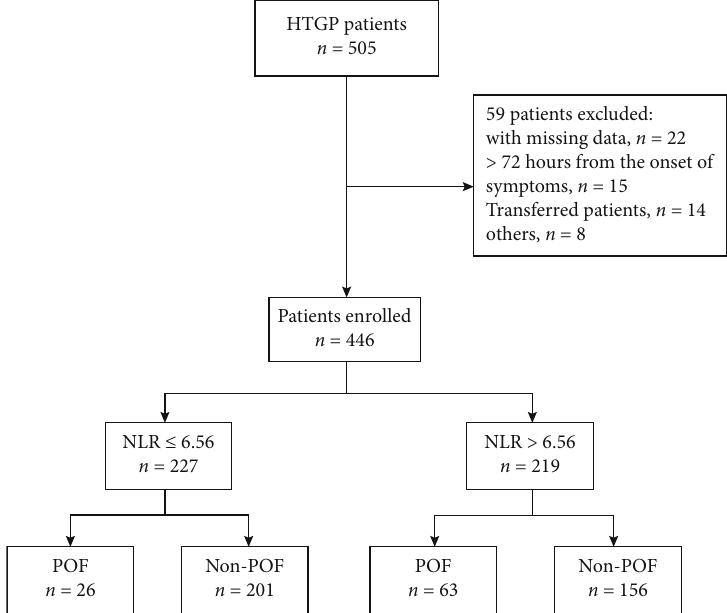
Figure 1: Flow chart of patient enrollment. HTGP: hypertriglyceridemia-induced acute pancreatitis; NLR: neutrophil-lymphocyte ratio; POF: persistent organ